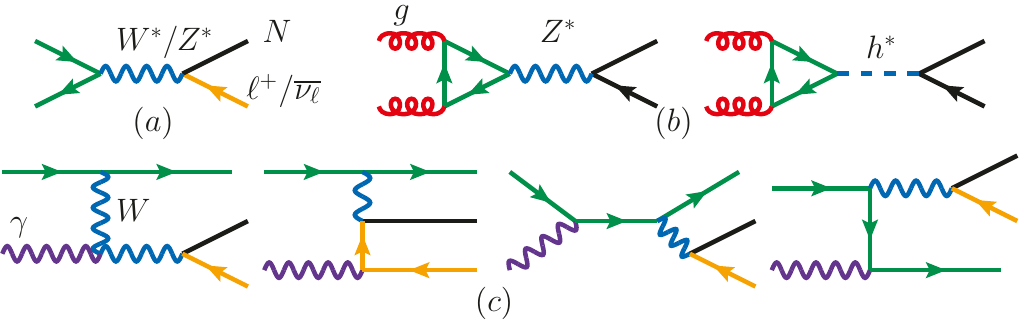
Figure 1. Born diagrams for leading heavy neutrino production mechanisms in hadron collisions. Diagrams throughout this text are drawn using JaxoDraw